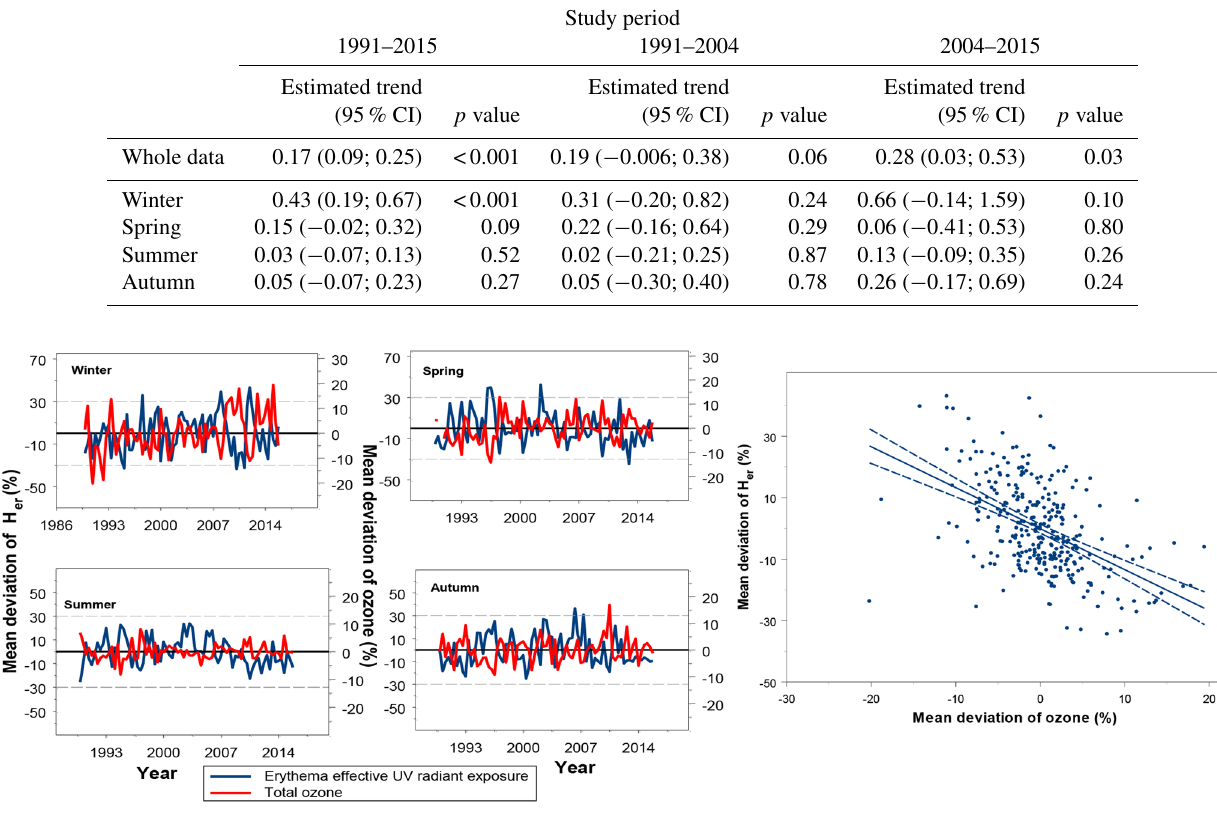
Table 3. Estimated trends (in %yr − 1 ) for TO with 95% CI in southern England for the monthly mean deviation data and for each season using various study periods.